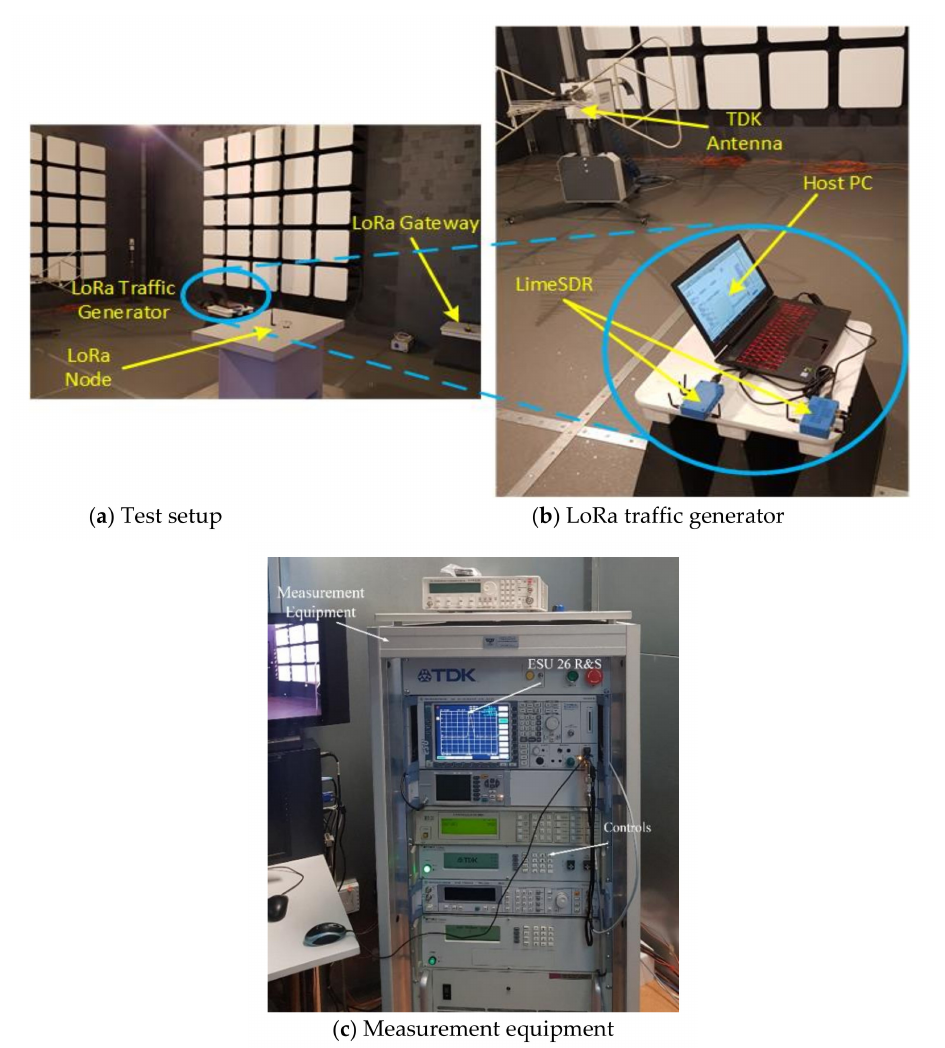
Figure 10. Performance evaluation test setup. ( a ) presents the test setup configuration. ( b ) depicts the tra ffi c generator that has been realized by using two SDRs of a LimeSDR type and the host PC, which runs the application. ( c ) presents the measurement